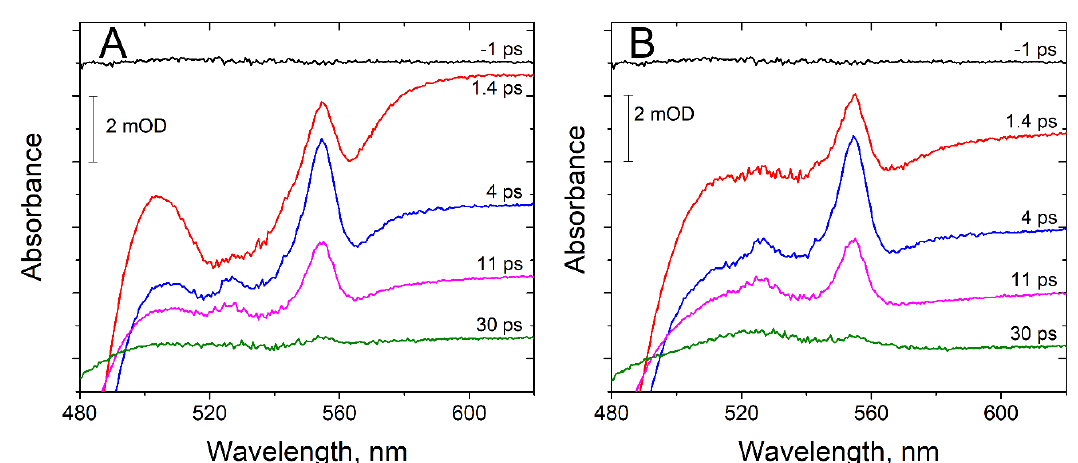
Figure 2. Spectral changes in K52C-Ru biohybrid at selected time delays in pump-probe transient absorbance experiments. ( A ): chirp-subtracted differential spectral changes vs. equilibrium ~1 ms after the pump pulses. Time delays are shown on the right of each spectrum. The spectra are vertically offset for clarity. ( B ): transient absorbance spectra with contributions from excited state hemes subtracted.